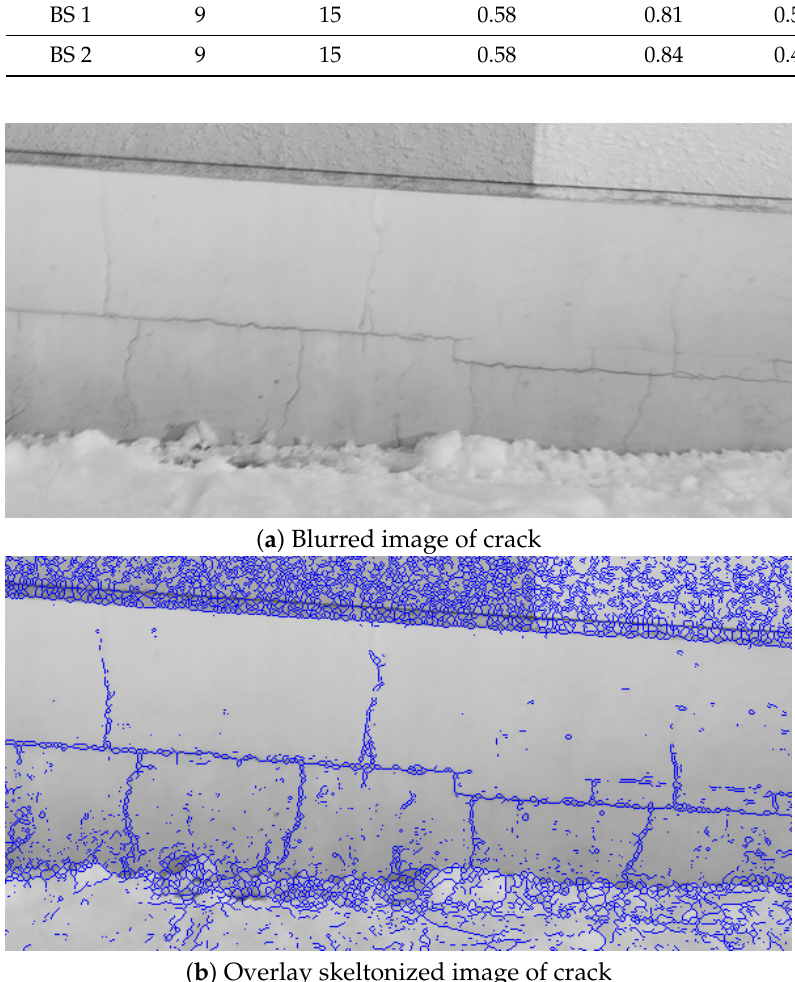
Figure 18. Blurred image and overlay skeltonized image of